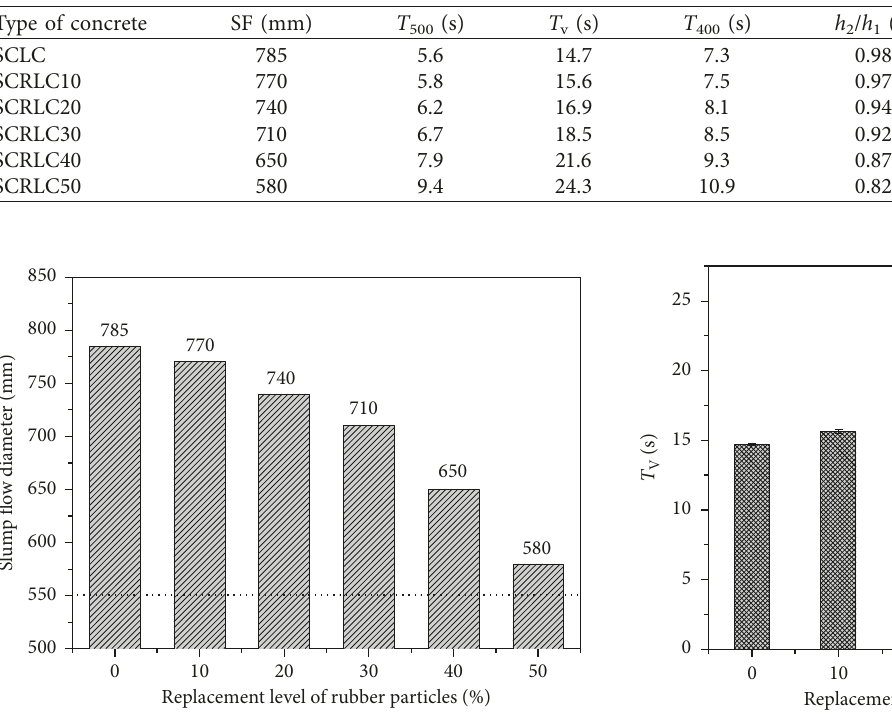
Figure 13: Effect of the replacement level of rubber particles on slump flow.